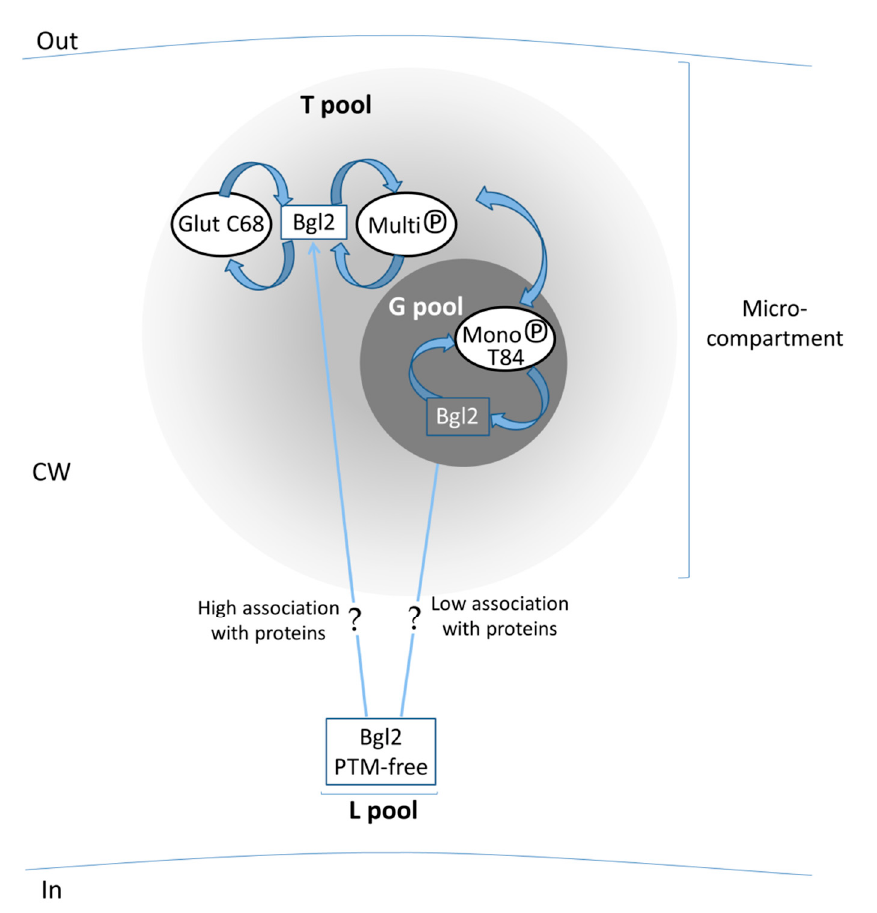
Figure 6. The hypothetical scheme of Saccharomyces cerevisiae cell wall segment with a microcompartment. We suppose that PTM-free Bgl2 enters the cell wall as a part of L pool. Depending on the degree of association with proteins in L pool, Bgl2 is directed to T or G pool. Probably, Bgl2, acquiring one or another set of PTMs, can migrate between T and G pools. In these two pools, at least some of the molecules are closely located, therefore, we suppose that they form the microcompartment. The localization of L pool could not be revealed. It is possible that proteins of L pool are dispersed rather than compactly located in the cell wall. Glut—glutathionylation, Multi P and Mono P —multi- and monophosphorylation, respectively.